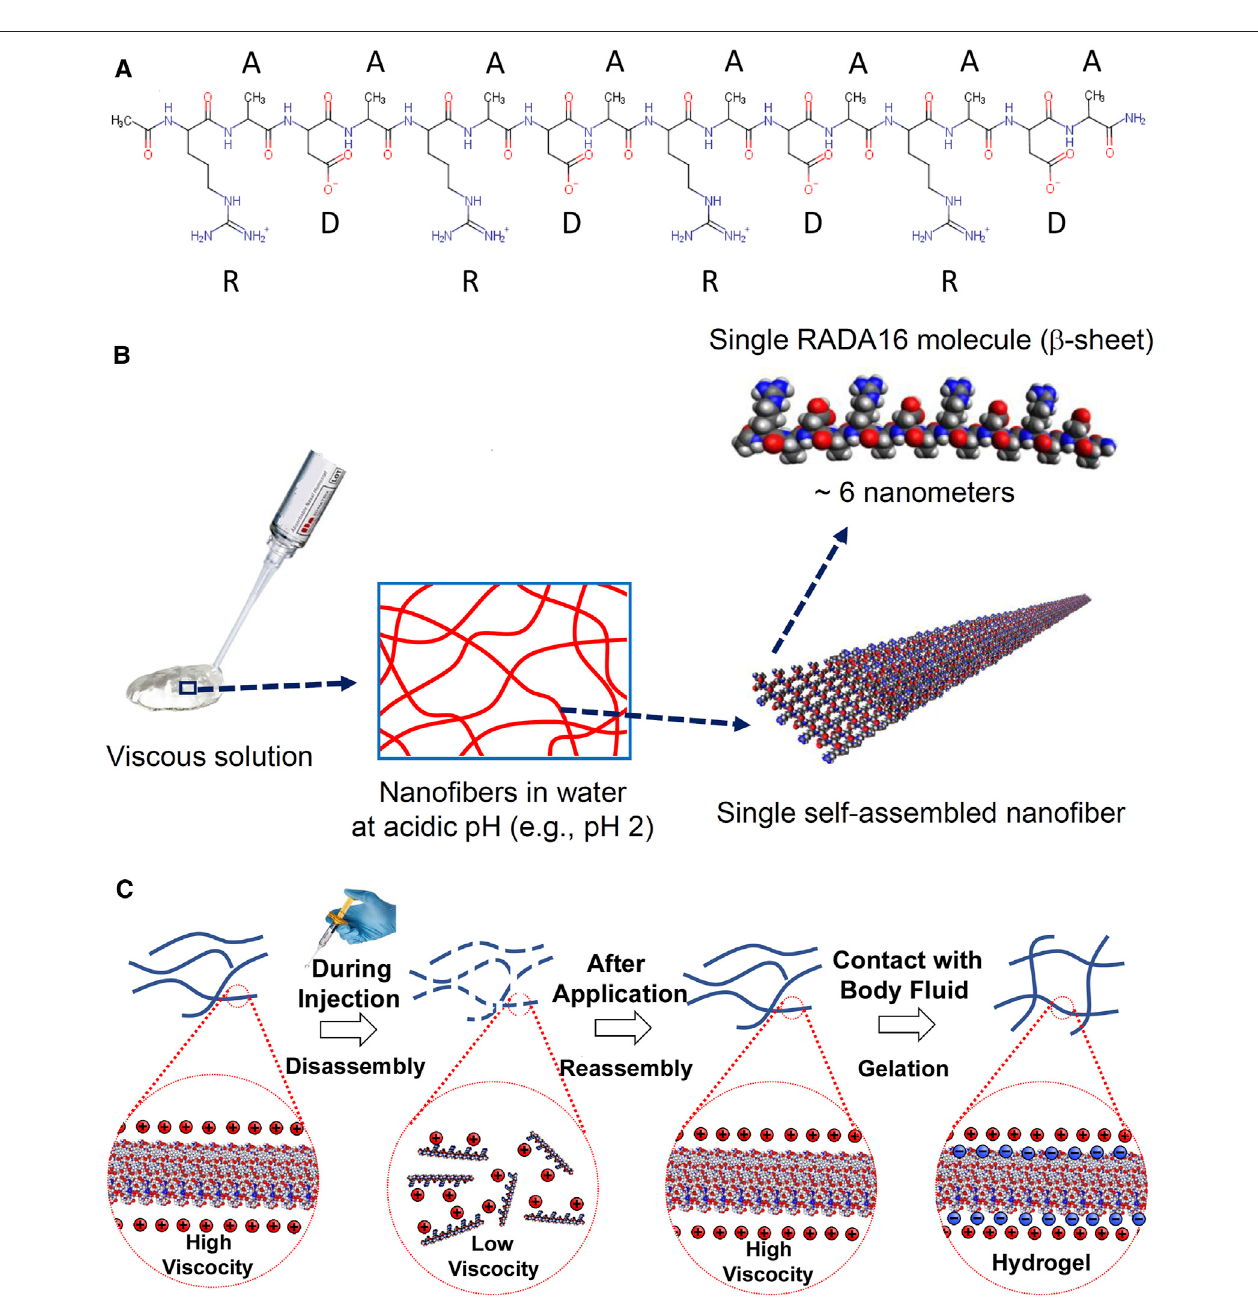
FIGURE1| Chemicalstructureandself-assemblyofRADA16intohigher-order hydrogels. (A) :TheRADA16peptidehas16aminoacidsorganized asrepeated4- amino acid sequences containing “ R ” (positively-charged arginine), “ A ” (hydrophobic alanine), and “ D ” (negatively-charged aspartic acid) residues. (B) : RADA16 undergoes spontaneous and revisable self-assembly in acidic solutions to generate nano fi bers. RADA16 molecules with β -sheet conformation interact through face-to- face hydrophobic interactions and edge-to-edge hydrogen bonding to form layered and extended nano fi bers, ∼ 6 nm wide. These extracellular matrix-like nano fi bers form aviscous and transparent aqueous solution at arelativelylow concentration range (e.g., 0.1 – 2.5% weight/volume). (C) :Illustrationof RADA16 structure and properties as it is applied to and gels on a wound site. Acidic aqueous solutions of RADA16 are viscous and exhibit thixotropic disassembly/reassembly, which allows their easy administration to wound sites through catheters and syringes, with viscosity returning immediately after administration. Upon contact with the physiological pH of body fl uids including blood, lymph and interstitial fl uid, the surface net charges of RADA16 nano fi bers become zero resulting in the physical crosslinking by hydrophobic interactions between neighboring RADA16 nano fi bers, so that RADA16 solution forms in-situ hydrogels on the wound site and act as a physical adhesive that is hemostatic and supports wound healing. Adopted from Sankar et al., Front. Bioeng. Biotechnol . 2021; doi: 10.3389/fbioe.2021.679525, in accordance with Creative Commons Attribution License